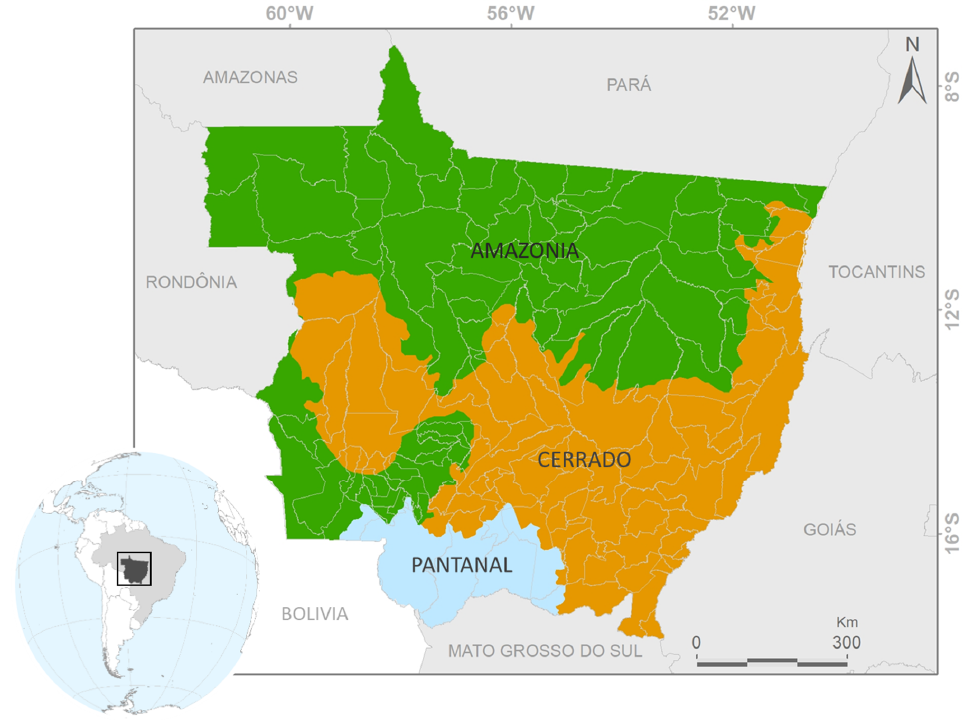
Figure 1. Location of the study area (Mato Grosso state) in Brazil (inset figure) and its coverage by three Brazilian biomes: Amazonia (rainfall forest, 57% of the state´s area), Cerrado (tropical savanna, 37%), and Pantanal (wetland, 6%). The blank lines are the boundaries of municipalities. Source: [35].